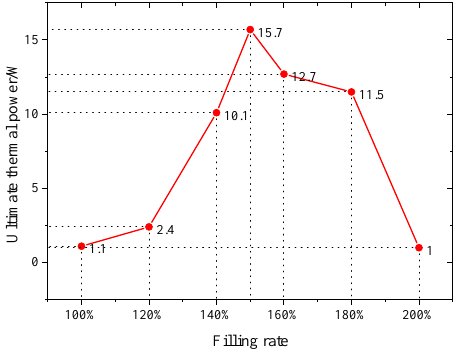
Figure 10. Maximum thermal power of CW-FMHP at different filling rates. 3.2.2. Comparation of CW-FMHP, CFW-FMHP and OCW-FMHP Since the optimal filling rate for the CW-FMHP is around 150%, three filling rates of 140%, 150%, and 160% are chosen for the comparison to study the wick structures. The axial temperature distributions of CFW-FMHP and OCW-FMHP under different filling rates at different thermal powers are shown in Figures 11 and 12. Their maximum thermal power values are listed in Table